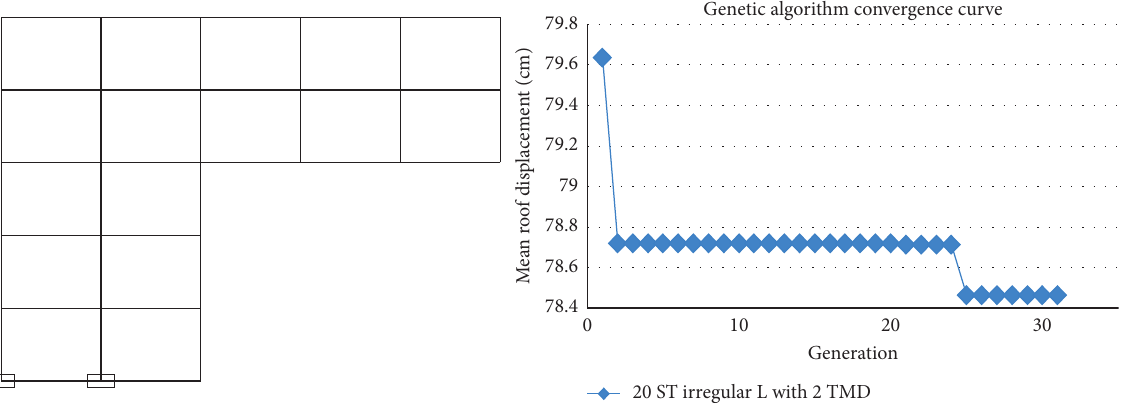
Figure 28: Convergence diagram of the twenty-story irregular L-shaped model with 2 dampers in genetic algorithm (right) and damper optimal positions (left).